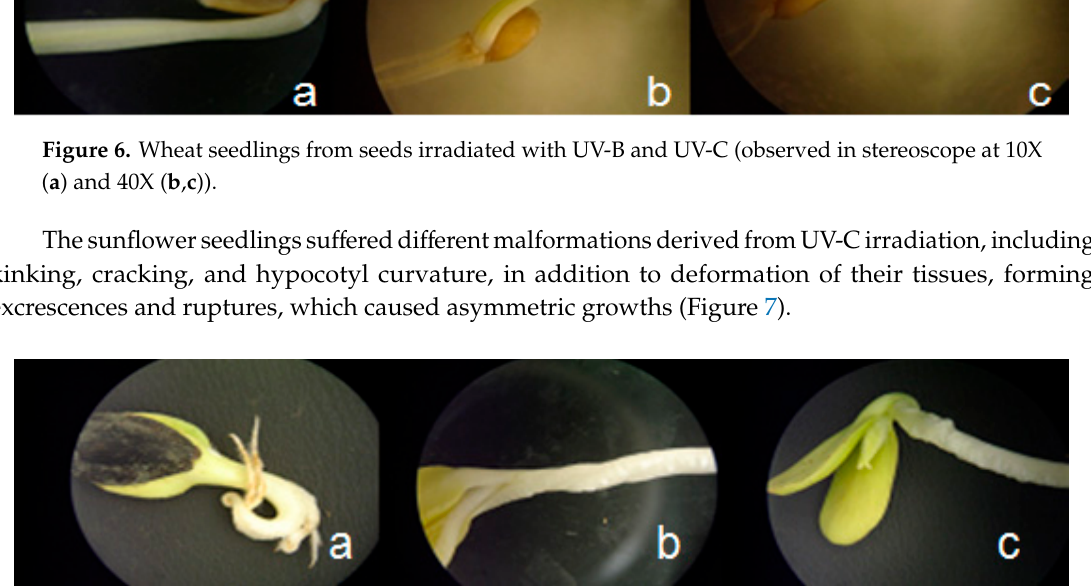
Figure 7. Sunflower seedlings from seeds irradiated with UV-B and UV-C (observed in stereoscope at 10X ( a ) and 40X ( b , c )).